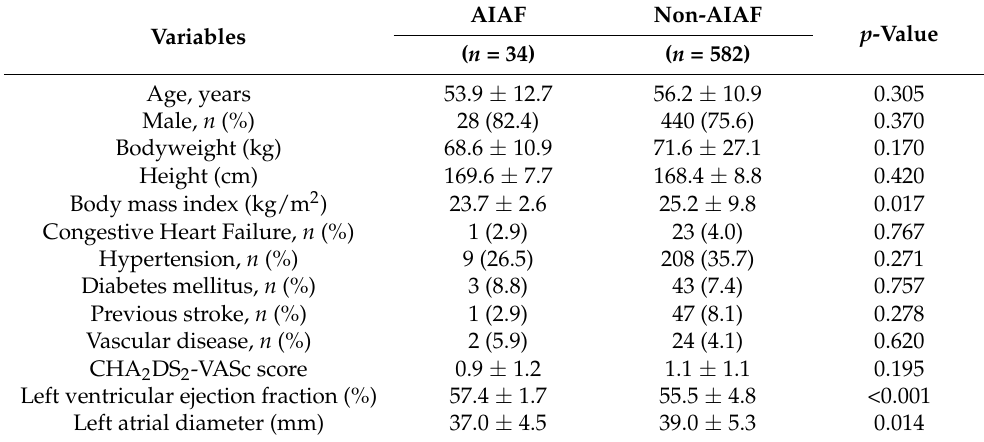
Table 1. Baseline characteristics of the study population. AIAF = adenosine-induced atrial fibrillation.